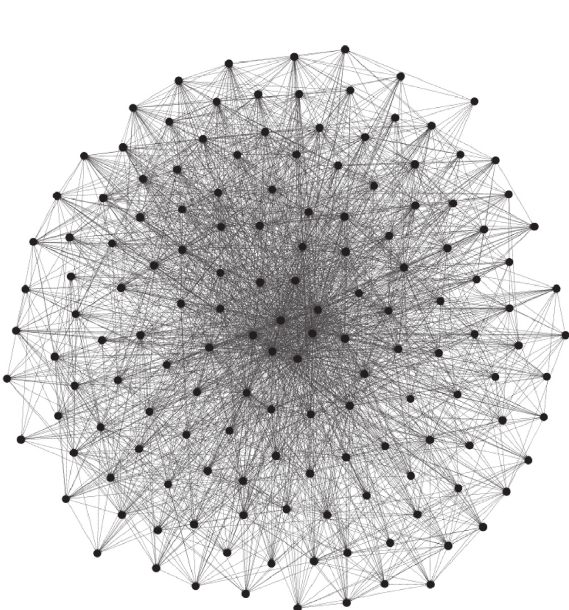
Figure 1: China’s overall industrial related